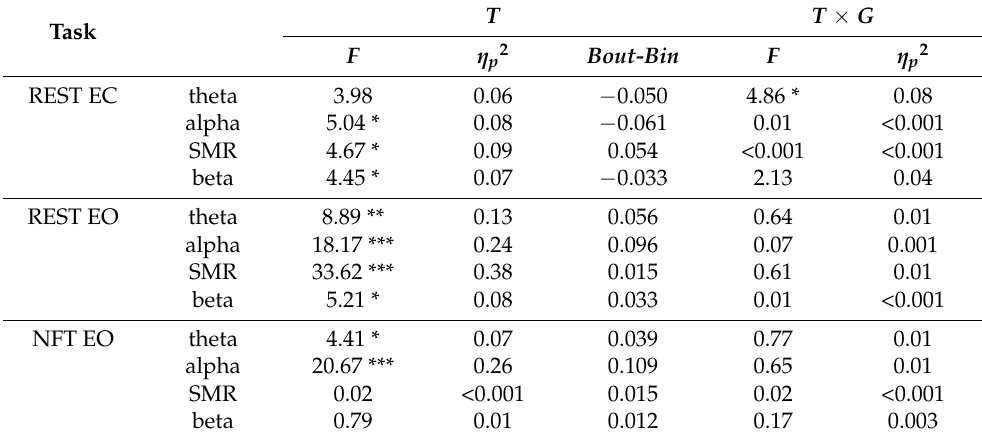
Table 2. RM ANOVA of pre-(Bin) and postintervention (Bout) power spectra for three